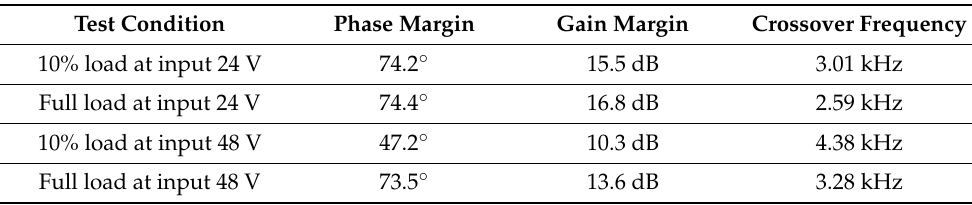
Table 4. Comparison of the proposed method and other